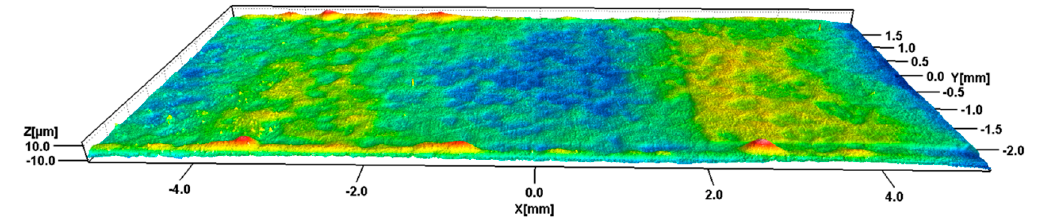
Figure 11. Part without blisters on the film insert surface (Z-axis scale 10:1) Molding parameters: T m : 60 °C, T b : 235 °C, P p : 126 bar, V i : 300 mm/s.